Question: Sum up the contents of this chart in one sentence.
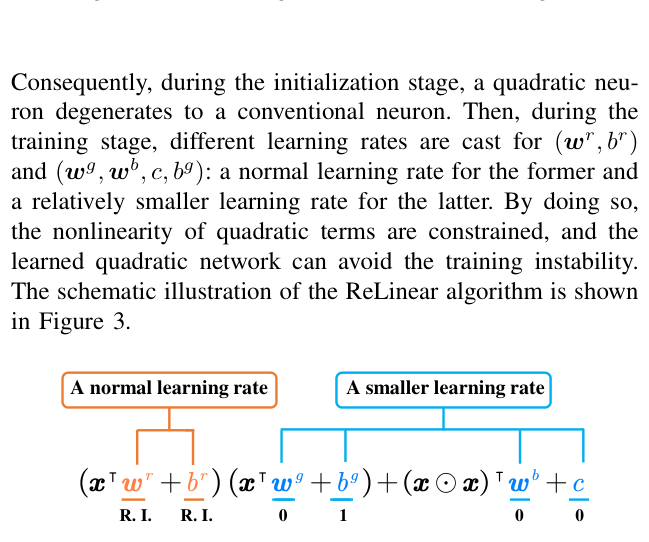
Answer: ReLinear: a training strategy of quadratic networks (R. I. means random initialization).